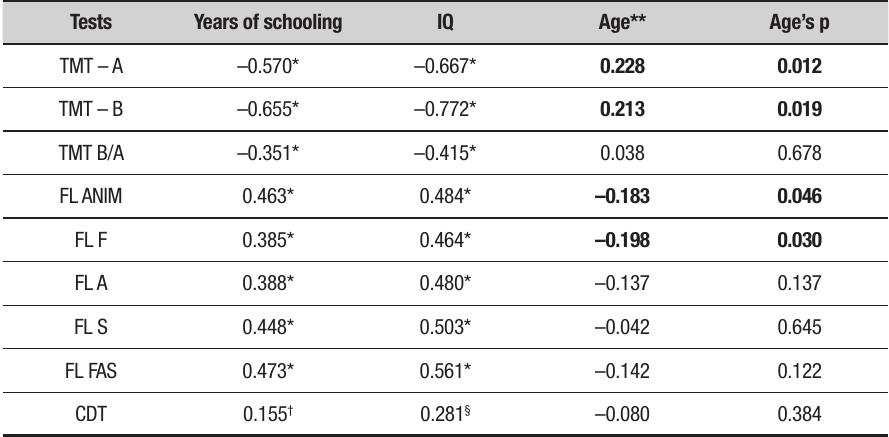
Table 5. Spearman’s correlations (rs) between tests results and independent